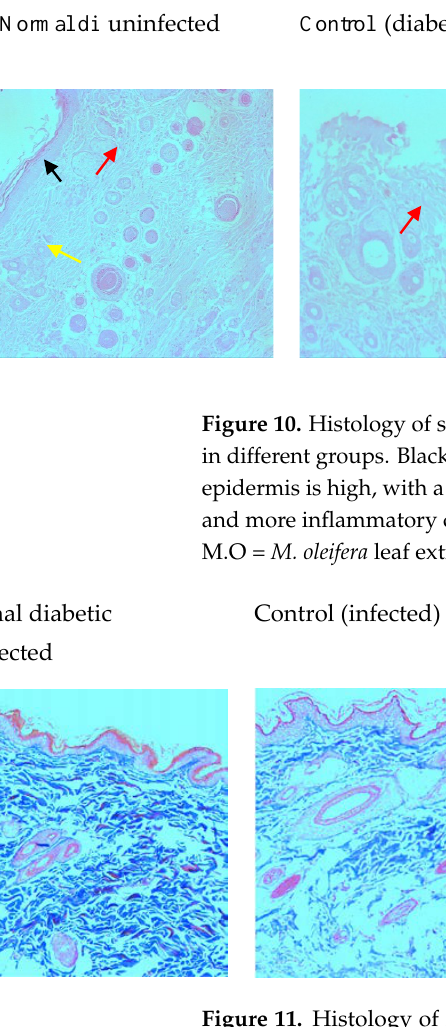
Figure 11. Histology of skin from diabetic animals infected with P. aeruginosa stained with Masson’s trichrome stain (100 × ). Skin tissue sections stained with Masson’s trichrome stain showing much less collagen in the control group and maximum collagen in the gentamicin-treated group, with an intermediate amount in the M. oleifera- treated groups. M.O = M. oleifera leaf extract formulation, GEN = gentamicin (0.1% w / w ).